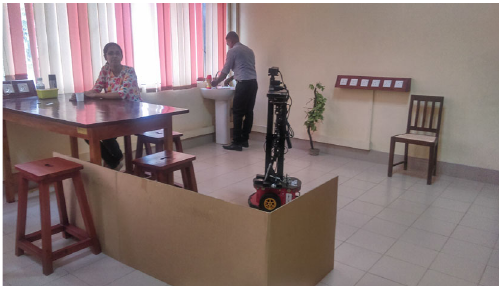
Figure 7: A situation in which the user was having a drink and in the surrounding, there was another human without an interaction with the user. Robot approached the user and initiated a